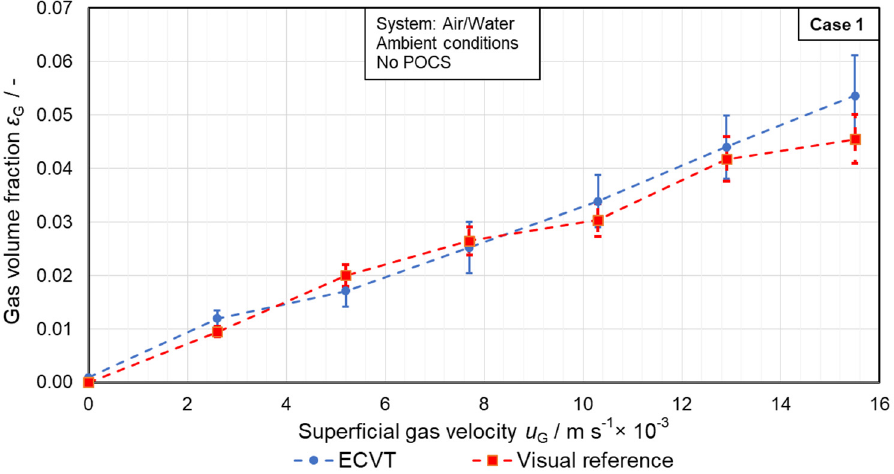
Figure 5. Comparison of the overall gas volume fraction in water without packing; ECVT (blue) versus volume expansion method (red).